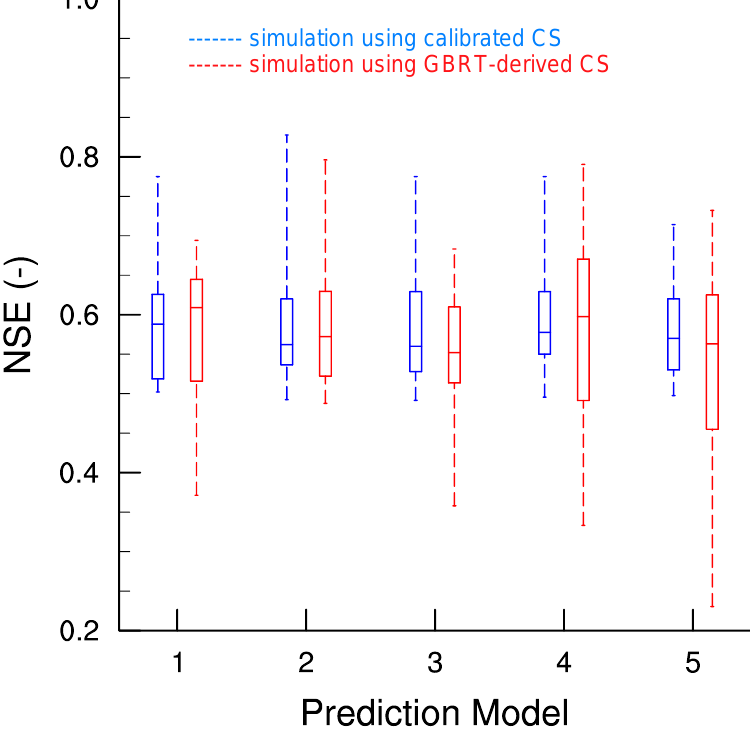
Figure 7. Box plot of Nash–Sutcliffe model efficiency coefficient (NSE) of XAJ-simulated streamflow during validation period. Each bar shows the distribution of NSE of 114 catchments with calibrated CS (blue) and GBRT-derived CS